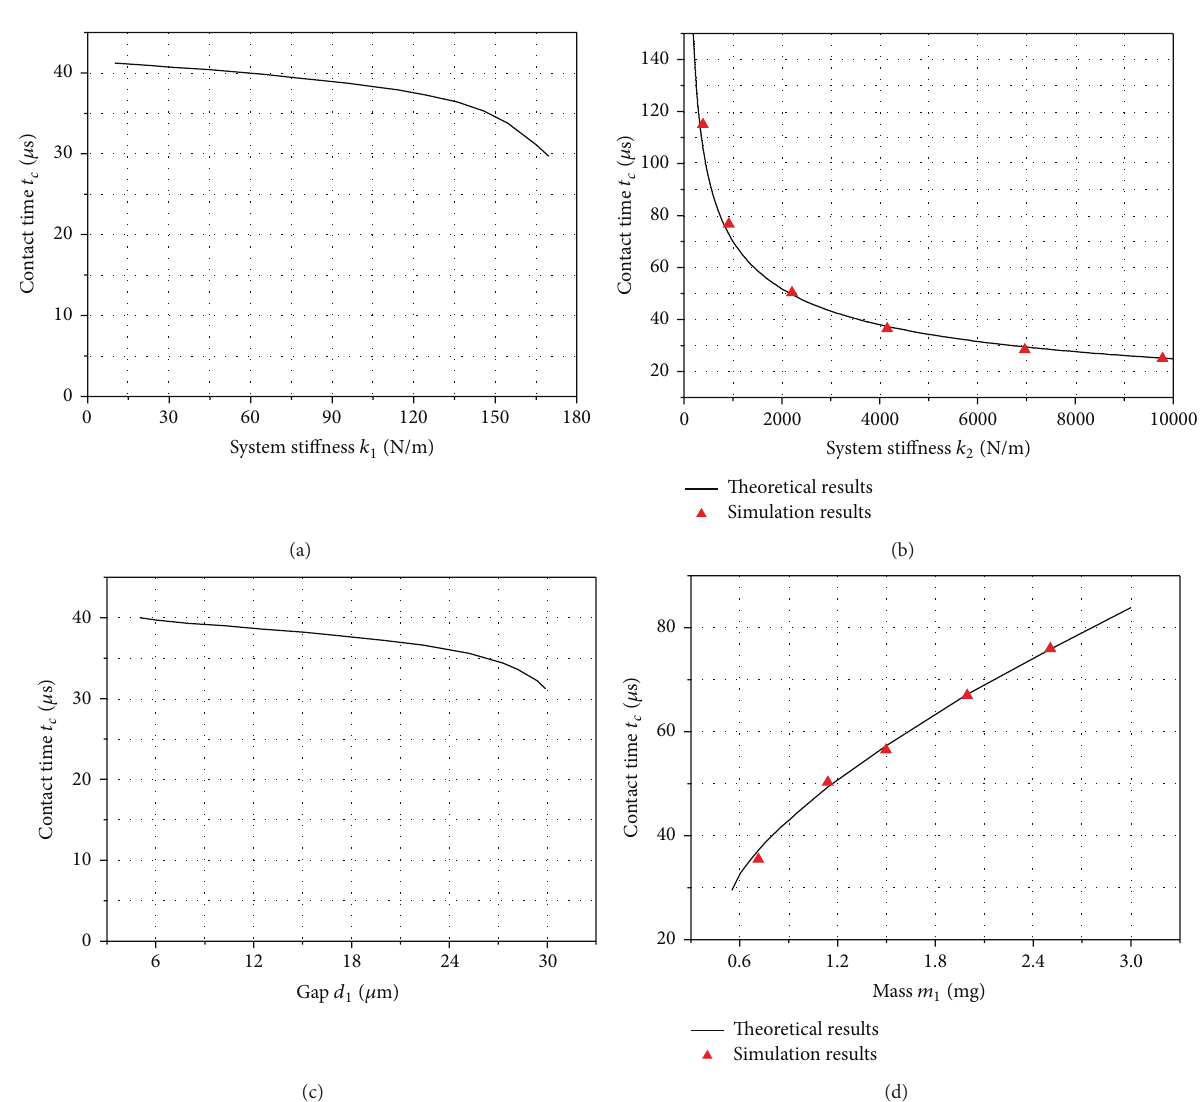
Figure 4: The curves of (a) the contact time versus system stiffness 𝑘 1 , (b) the contact time versus system stiffness 𝑘 2 , (c) the contact time versus gap 𝑑 1 , and (d) the contact time versus mass 𝑚 1